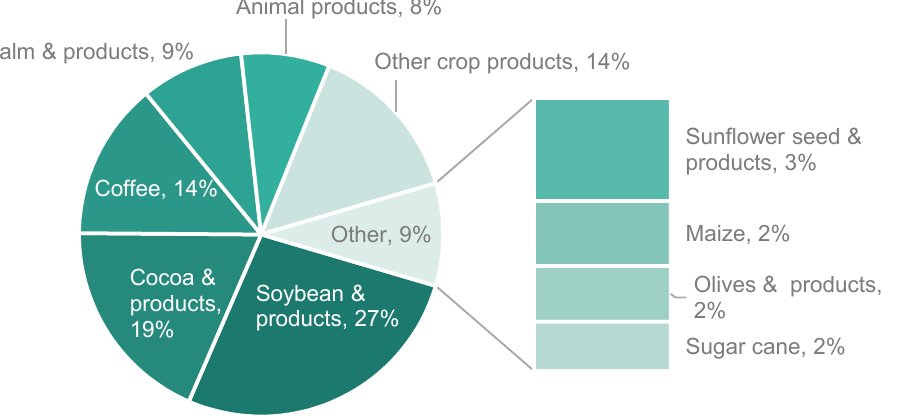
Figure 2. Green virtual water import to the EU by product group, average for 2006–2013. Agricultural products account for largest 67% of the blue water footprint of imported products: Rice (9%), sugarcane (7%), cotton (7%), almonds (4%), pistachios (3%), animal products (3%), grapes and wine (3%), and soybean products (3%) (Figure 3).